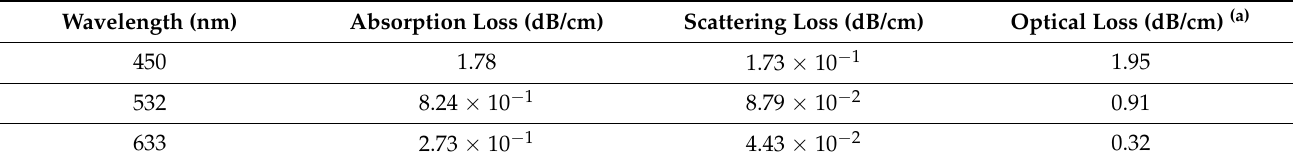
Table 1. Contributions to attenuation at the three exciting wavelengths used for the measurements.